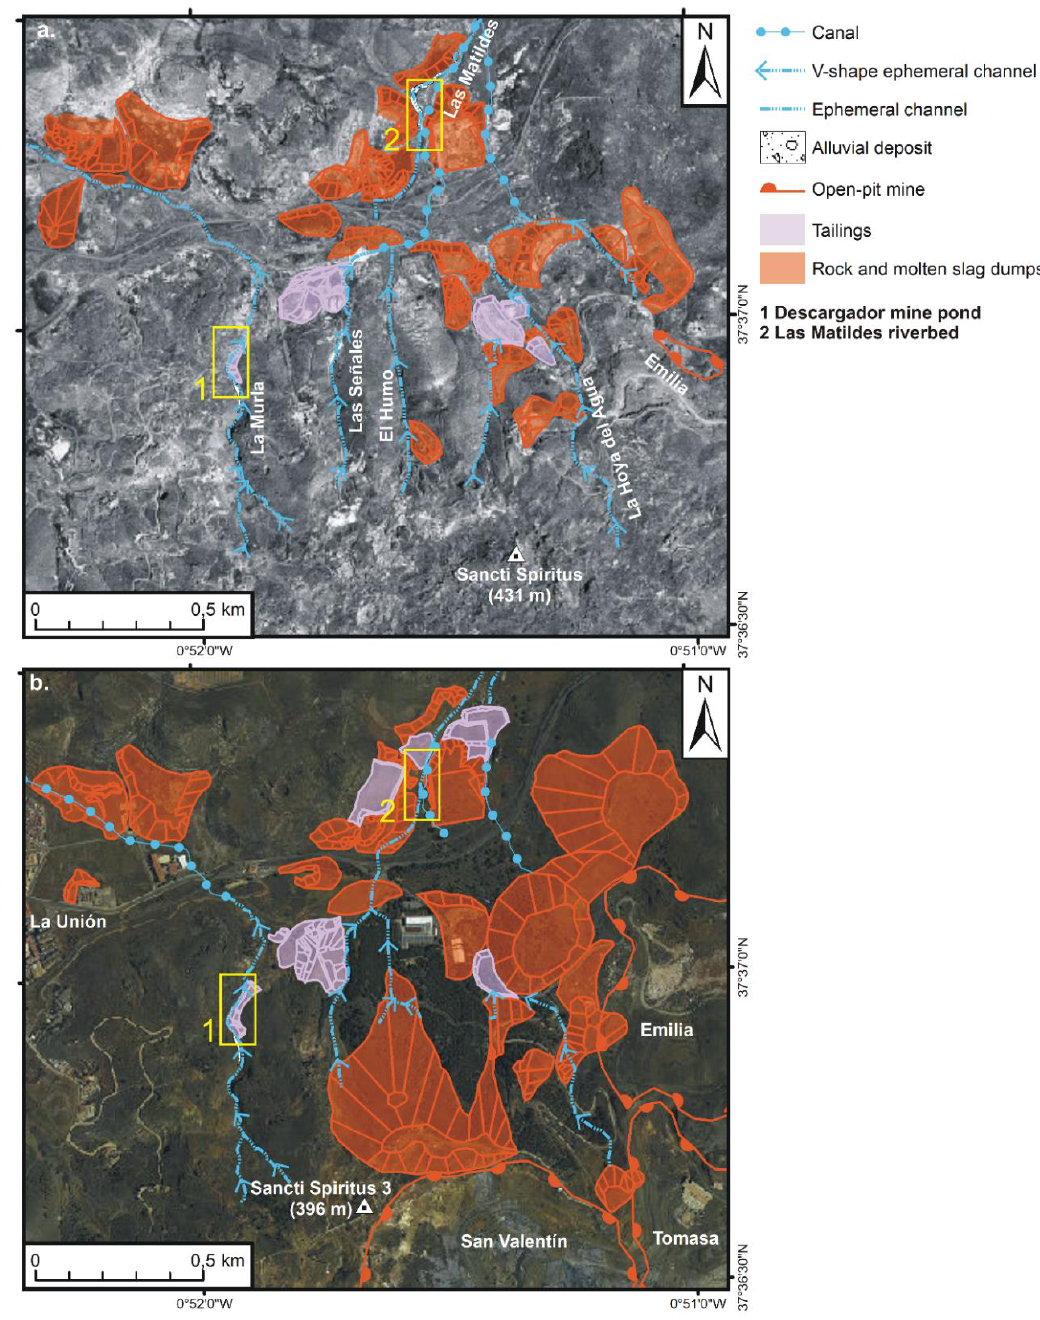
Figure 2. Mapping of the temporal evolution of the mining landscape to the east of La Unión town: ( a ) orthoimage from 1956 (Cartography Service of the Murcia Region); ( b ) orthoimage from 2016 (Cartography Service of the Murcia Region). Yellow rectangles: areas where geophysical prospection has been carried out: 1. Descargador mine pond, and 2. Las Matildes